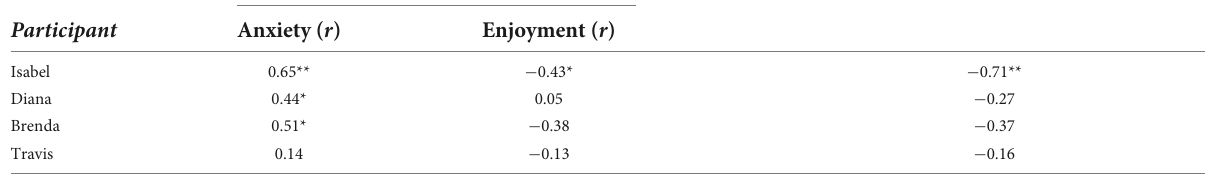
TABLE 2 Correlations between per-7-s ratings of enjoyment, anxiety and breakdown fluency for each participant. Correlation with breakdown fluency Correlation between anxiety and enjoyment ( r ) Participant Anxiety ( r